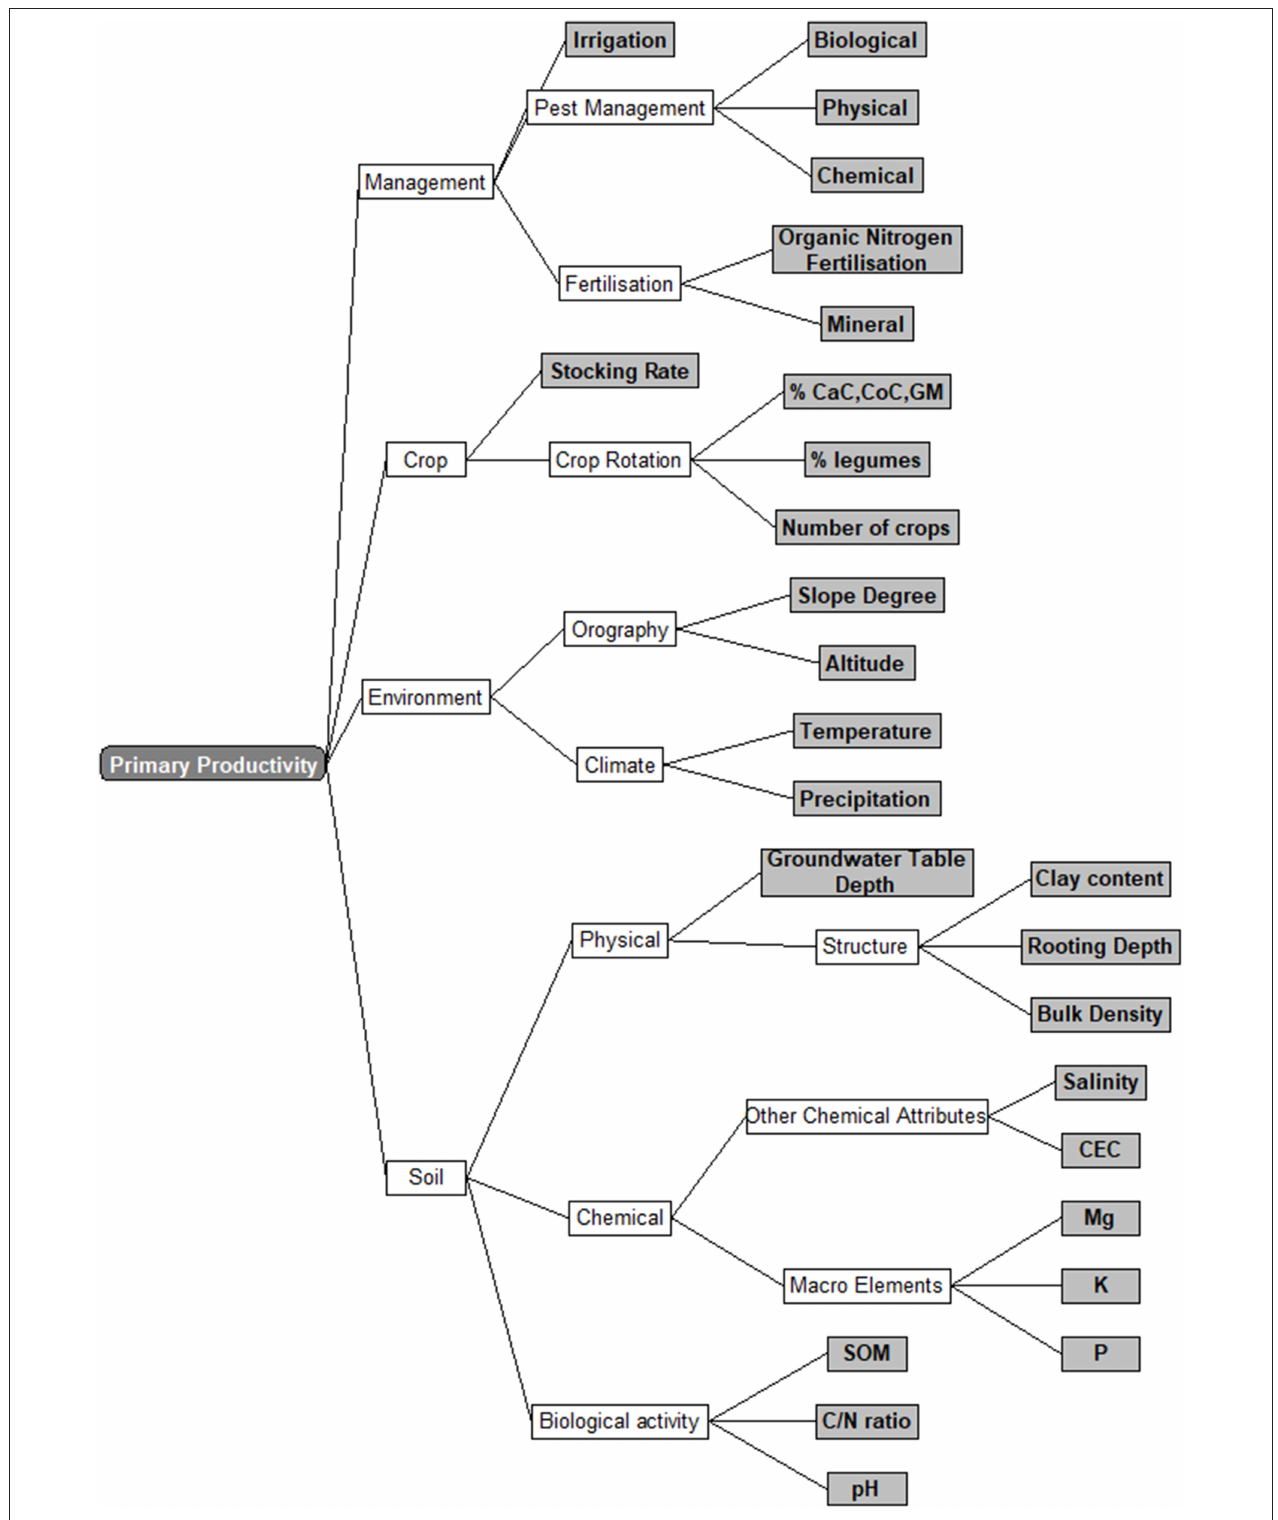
FIGURE 2 | The decision support model for primary productivity that is built up from basic attributes (gray boxes on right) via aggregated attributes (e.g., biological activity and soil) to the ultimate soil function—primary productivity.